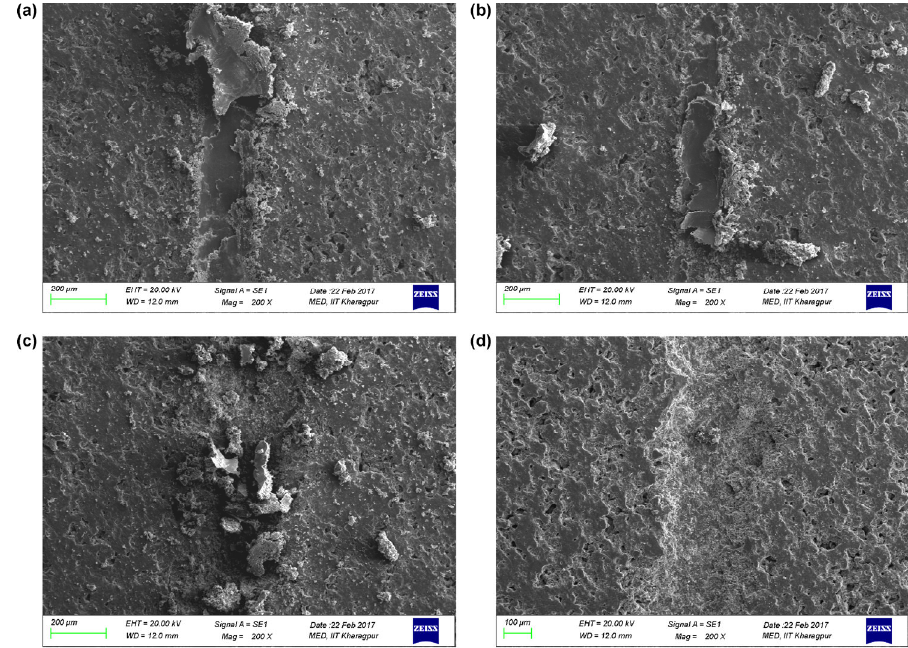
Fig. 9 SEM images of scratched surface at various